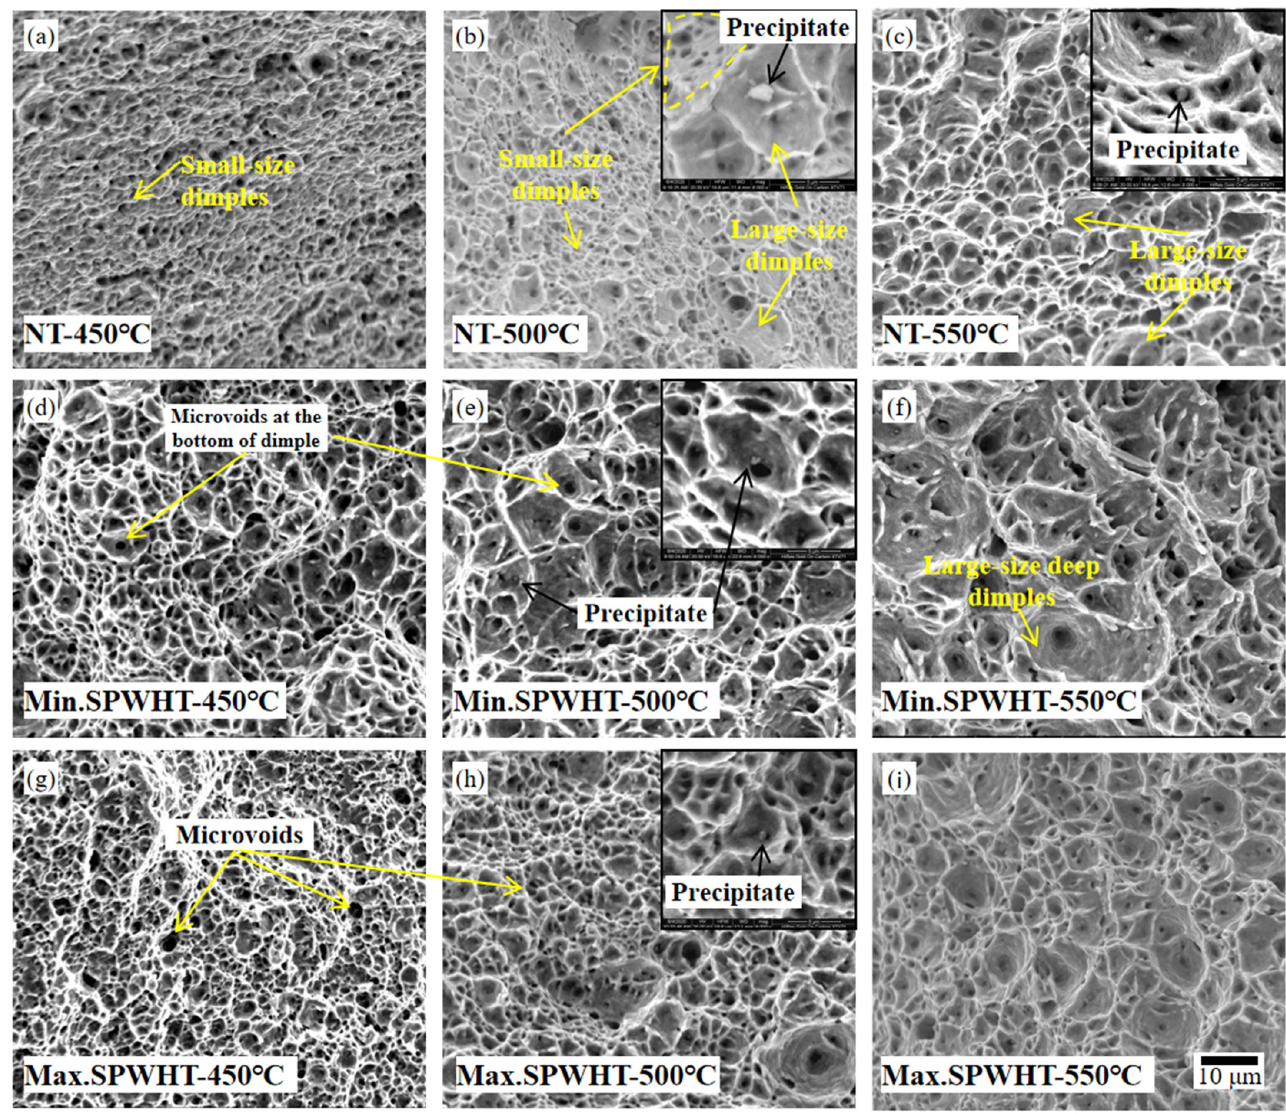
Figure 11. The micro-morphology of the fracture of the tensile specimens of the 2.25Cr1Mo0.25V steel in the ( a – c ) NT, ( d – f ) Min.SPWHT, and ( g – i ) Max.SPWHT states at 450–550 ◦ C.